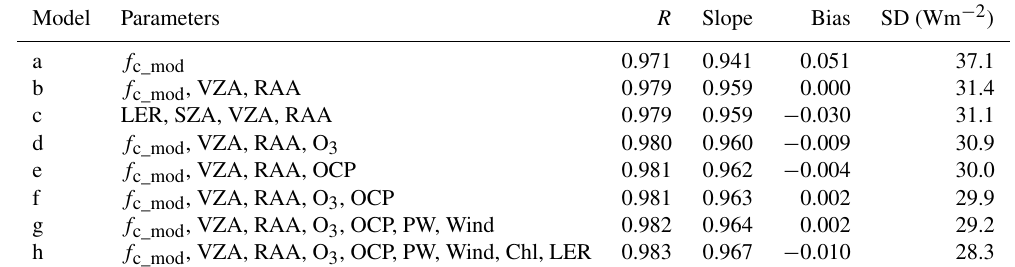
Table 1. Statistical analysis of the input parameter selection exercise. The correlation coefficient (R) , slope, bias, and standard deviation (SD) of OMI–CERES TOA SW flux for eight different NN models are presented. These numbers correspond to daily intercomparison between OMI and CERES TOA SW flux. Data from January 2007 are used for this exercise.